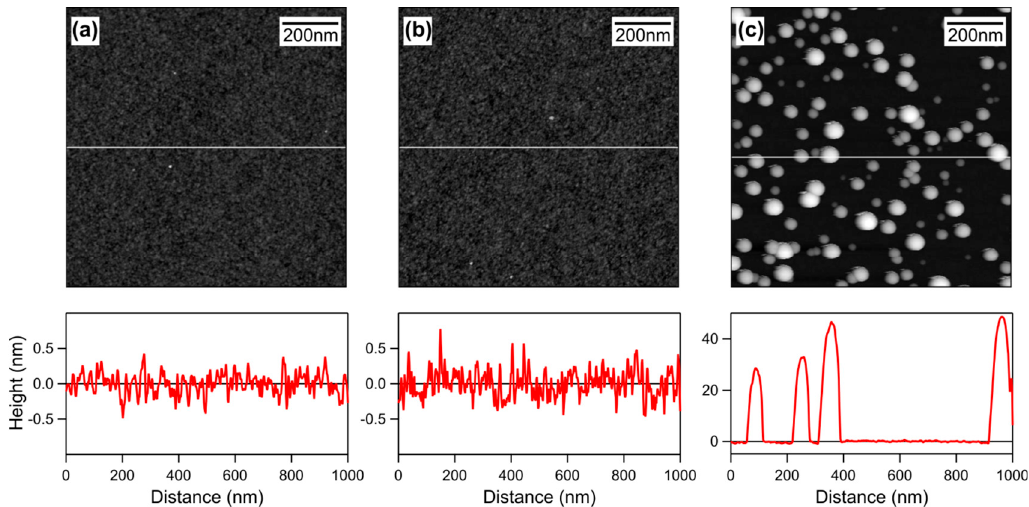
Figure 1. AFM topographical images and corresponding height profiles of the ( a ) bare silica substrate, ( b ) the PDADMAC-functionalized substrate, and ( c ) the functionalized substrate with deposited nanoparticles. The height profiles are indicated as horizontal lines in the images. The silica substrate was functionalized during 1 h in a PDADMAC solution with a concentration of 5.0 mg/L with pH 4.0 and an ionic strength of 10 mM, resulting in an adsorbed amount of 0.14 mg/m 2 . Sulfate latex nanoparticles were subsequently deposited during 30 min to this substrate from a suspension of 10 mg/L at pH 4.0 and an ionic strength of 1.1 mM. The ex situ method involving dip coating was used in both